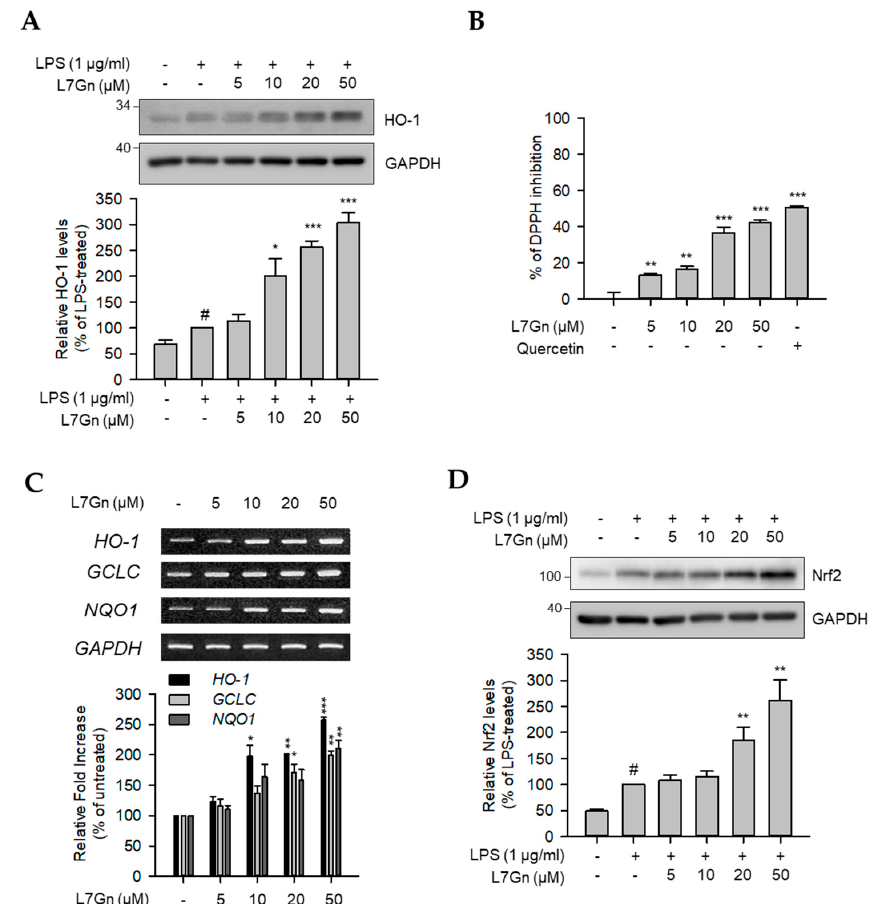
Figure 5. E ff ects of L7Gn on anti-oxidative regulators. RAW 264.7 cells were pre-treated with L7Gn for 2 h and then treated with LPS (1 µ g / mL) for 24 h for immunoblot analyses. ( A ) Total cell lysates were prepared and immunoblot analysis was performed. The expression of HO-1 was detected using specific antibodies. Expression levels of HO-1 were normalized to GAPDH levels. Results of the quantitative analyses of protein levels after normalization are shown (lower panel). Data represent the mean ± S.D. # p < 0.01 relative to the LPS-untreated control group. * p < 0.05 and *** p < 0.001 relative to the LPS-treated and 5 µ M L7Gn-treated group. ( B ) DPPH free radical scavenging activity was represented as the mean ± S.D. ** p < 0.01 and *** p < 0.001 relative to the non-treated group. ( C ) Total RNA was extracted and reverse transcribed to cDNA. HO-1 , GLCL , and NQO1 were amplified by PCR and detected on agarose gel. The representative data are shown. * p < 0.05, ** p < 0.01, and *** p < 0.001 relative to the untreated group. ( D ) Total cell lysates were prepared and immunoblot analysis was performed. The expression of Nrf2 was detected using specific antibodies. Expression levels of Nrf2 were normalized to GAPDH levels. Results of the quantitative analyses of protein levels after normalization are shown (lower panel). Data represent the mean ± S.D. # p < 0.01 relative to the LPS-untreated control group. * p < 0.05 and ** p < 0.01 relative to the LPS-treated and 5 µ M L7Gn-treated